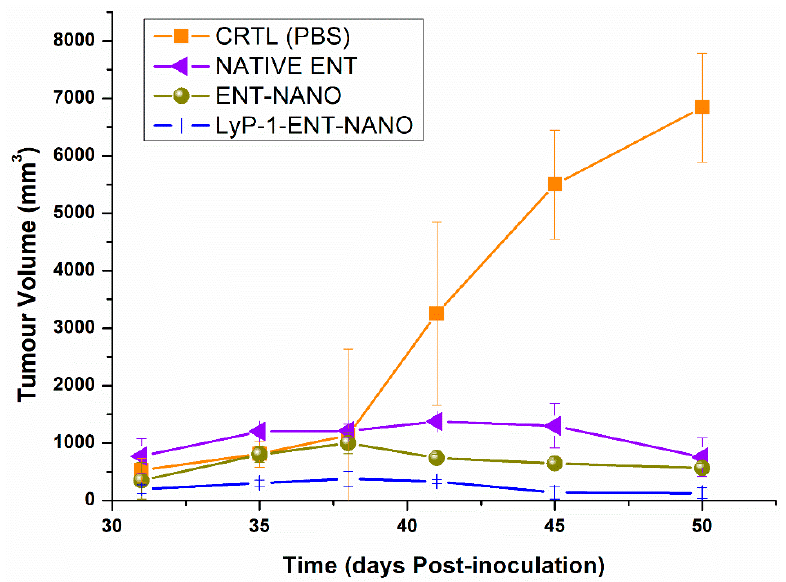
Figure 10. Therapeutic effects of the LyP-1-functionalized nanosystem treatment in KYSE-30 xenografts. Error bars indicate ± standard deviation.